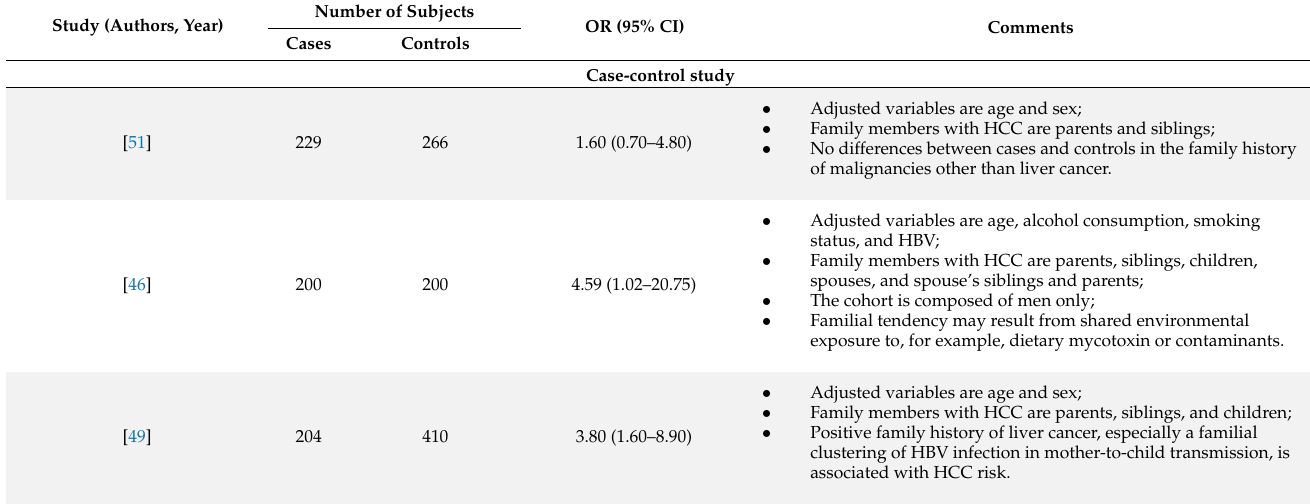
Table 1. Family History of